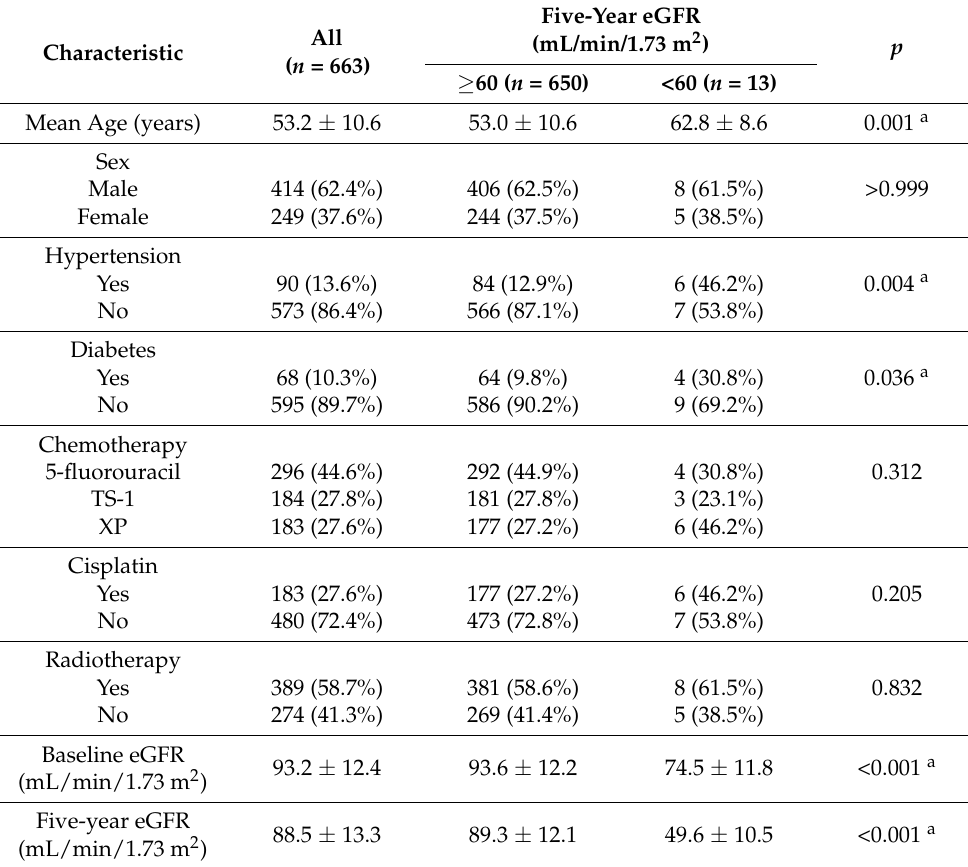
Table 1. Patient characteristics.